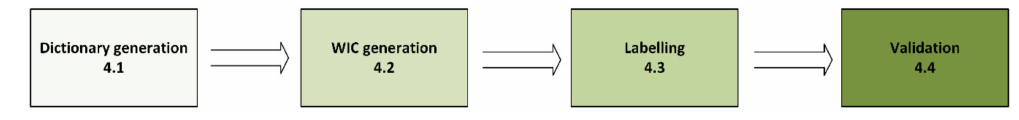
Figure 7. Summary of the